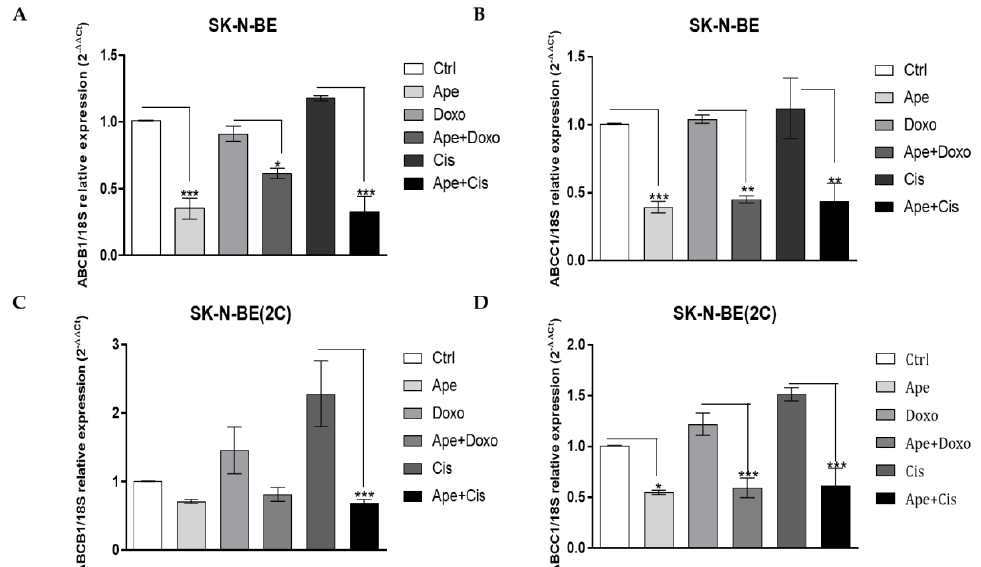
Figure 7. RT-PCR analysis showing the ABC-B1, ABC-C1 and ABC-C4 transcript levels in SK-N-BE ( A ) and SK-N-BE(2C) cell lines ( C ). Here, 18S used as housekeeping gene. RT-PCR analysis showing the ABC-B1, ABC-C1 and ABC-C4 transcript levels in SK-N-BE ( B ) and SK-N-BE(2C) ( D ) cell lines after 24 h of treatment with 100 µM APE. The graphs indicate the densitometric analysis of the bands of the transcript normalized with the housekeeping gene 18S. The results are the average ± SEM of three independent experiments performed in triplicate. (* p < 0.05; ** p < 0.01; t -test; APE vs. respective Ctrl).